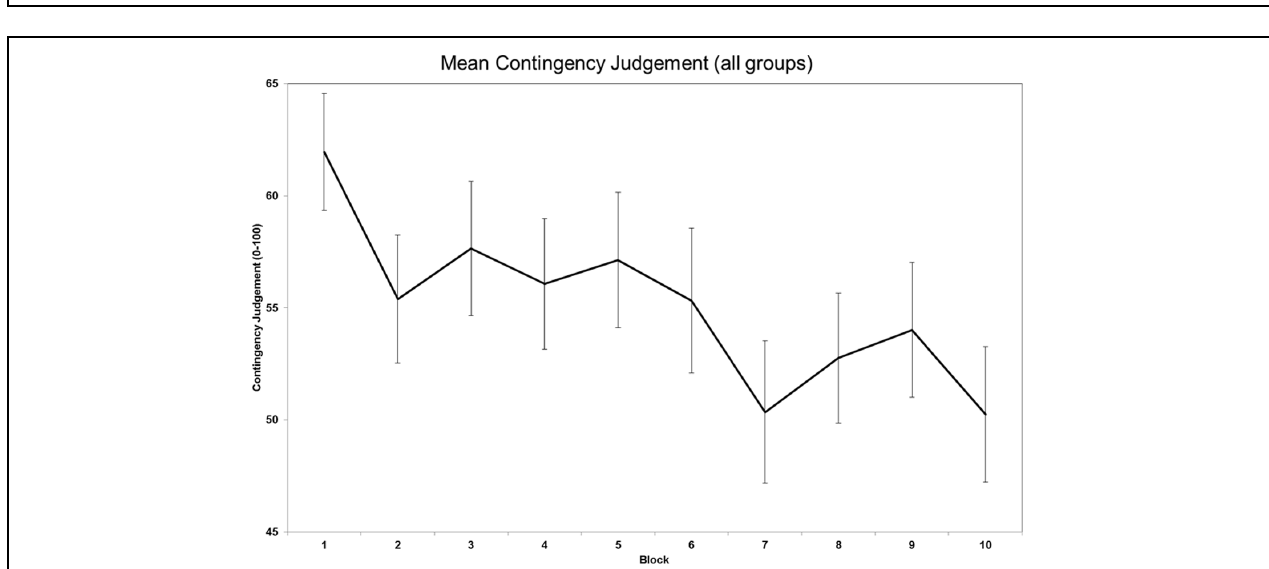
FIGURE 3 | Boxplot of depression status and proportion of gambles in extinction for each of the four conditions.